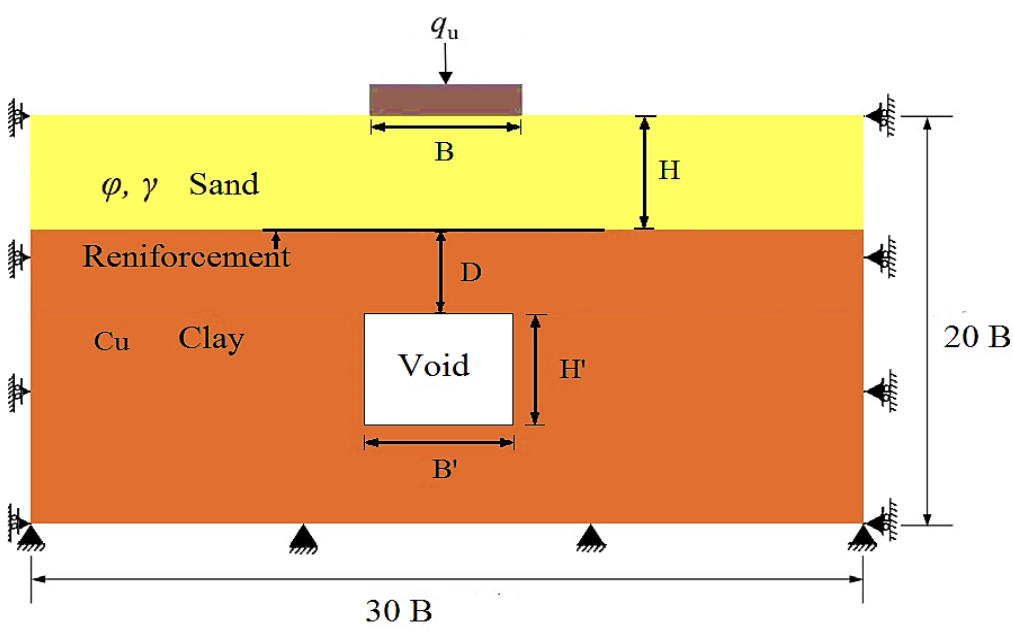
Figure 2. Strip footing above two-layered sand overlying clay with single